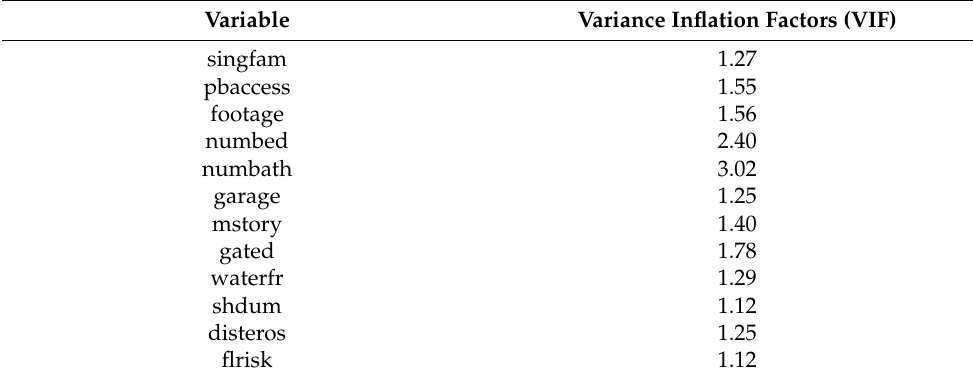
Table 3. Multicollinearity test